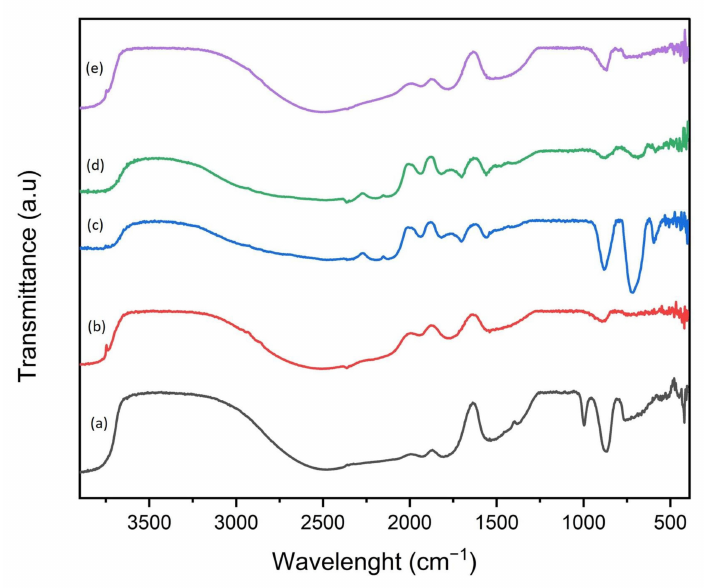
Figure 2. FTIR spectra of (a) SiO 2 (b) SiO 2 /Zr (c) SiO 2 -TEDTA (d) SiO 2 /Zr-TEDTA and (e) SiO 2